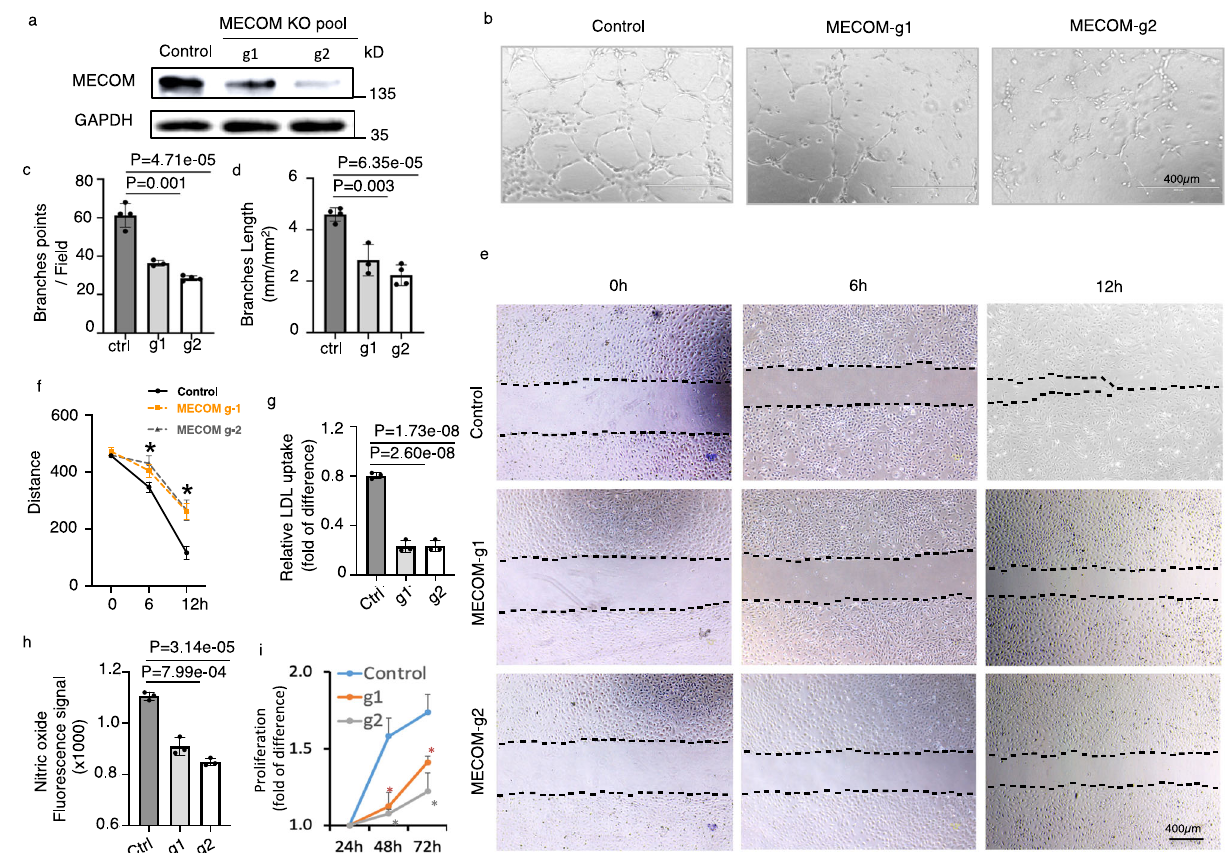
Fig.3|MECOMisrequiredforHUVECphenotypeandfunction.a Westernblotto show MECOMprotein levels. b Representative imagesof invitrotubeformation in control and MECOM-KO HUVECs pool. c The number of EC tube branching points per high power fi eld. d The length of EC branching tube. e Representative wound closure images at 0h, 6h, and 12h after scratch. f Distance between the two bor- ders (dotted lines in e ) in wound closure images. g , h LDL uptake ( g ) and Nitric